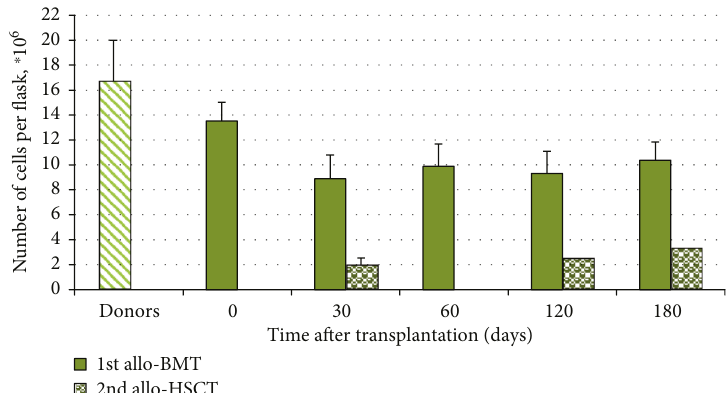
Figure 1: Cumulative MSC production for 3 passages in patients after allogeneic hematopoietic stem cell transplantation. The data are presented as the mean ± standard error (M ± SE), donors — 88 MSC samples; patients before allo-BMT (point 0) — 44 samples; patients after 1st allo-BMT — 35 samples; patients after 2nd allo-HSCT — 5 samples for 30 days and 2 samples for 120 and 180 days. Table 4: Proportion of donor cells in the bone marrow (BM), CFU-Fs, and MSCs. Proportion of donor chimerism,